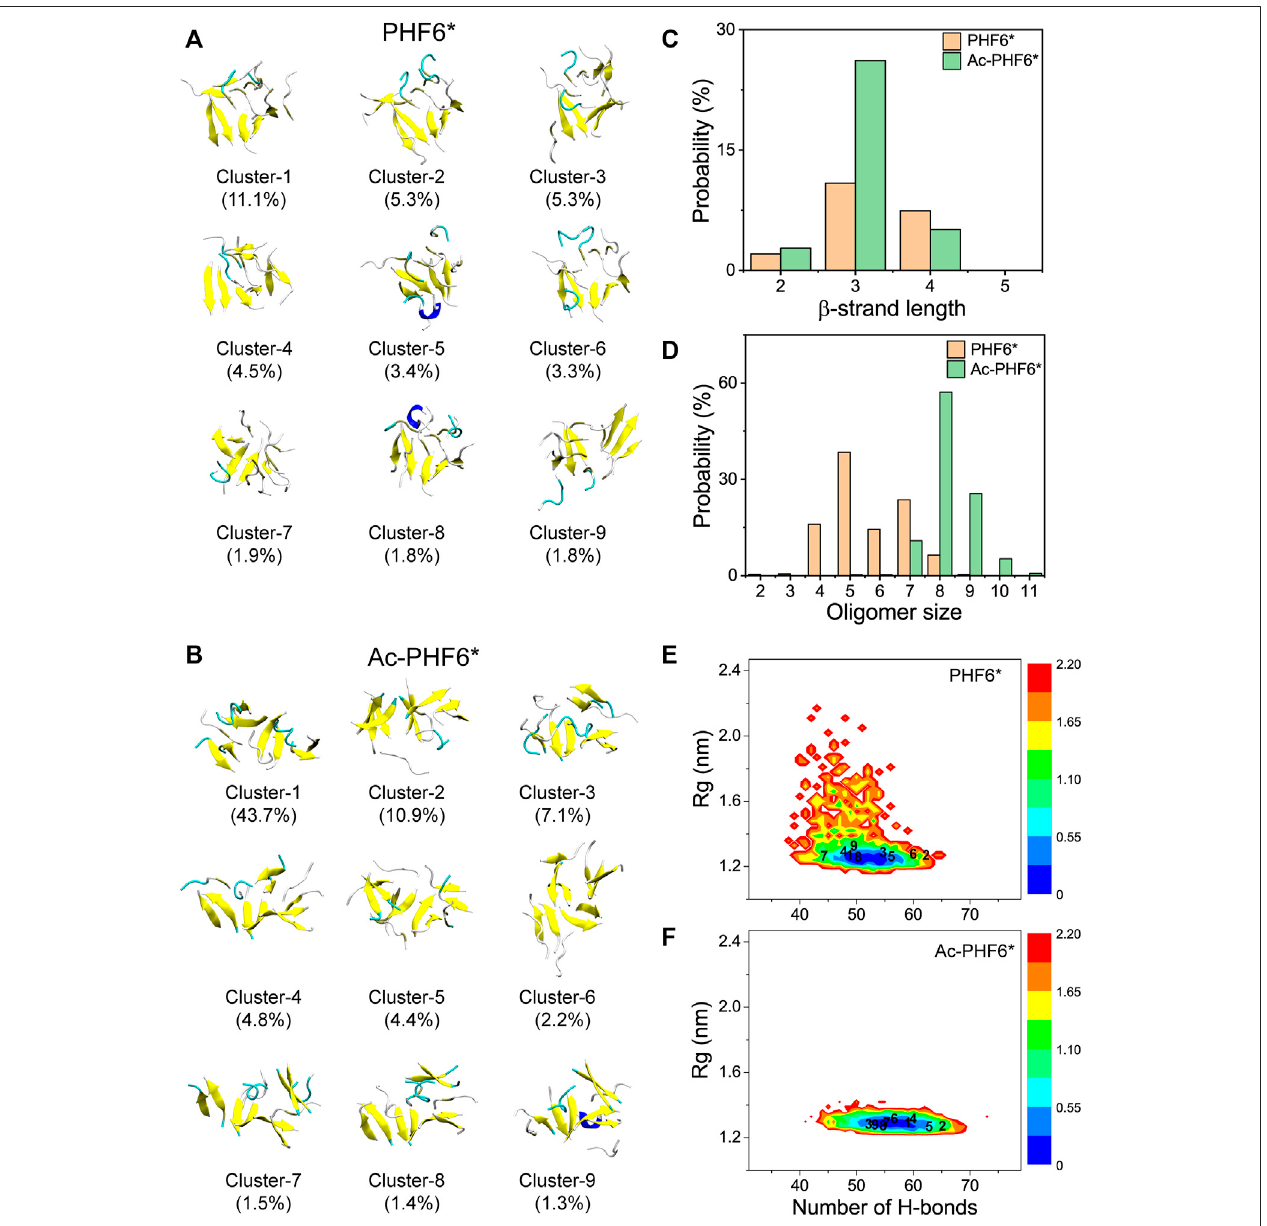
FIGURE 2 | Representative conformations of the fi rst nine most-populated clusters of PHF6* oligomers in PHF6* (A) and Ac-PHF6* (B) systems. The corresponding population of each cluster is given in parentheses. Probability of the β -strand length (C) and different sizes of oligomers (D) in two systems. The potential of mean force (PMF) (or free energy surface) (in kcal mol − 1 ) of PHF6* oligomers in PHF6* (E) and Ac-PHF6* (F) systems projected on two reaction coordinates: the H-bond number and the Rg of the PHF6* oligomers. The numbers in the PMF correspond to the cluster